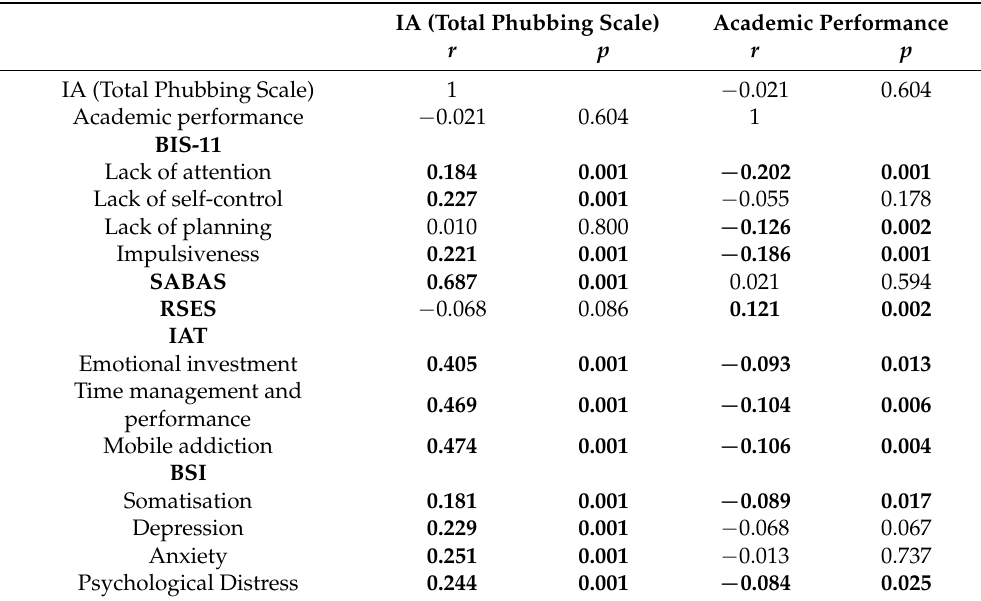
Table 5. Correlation between IA (Total Phubbing Scale) and the rest of the psychological variables and academic